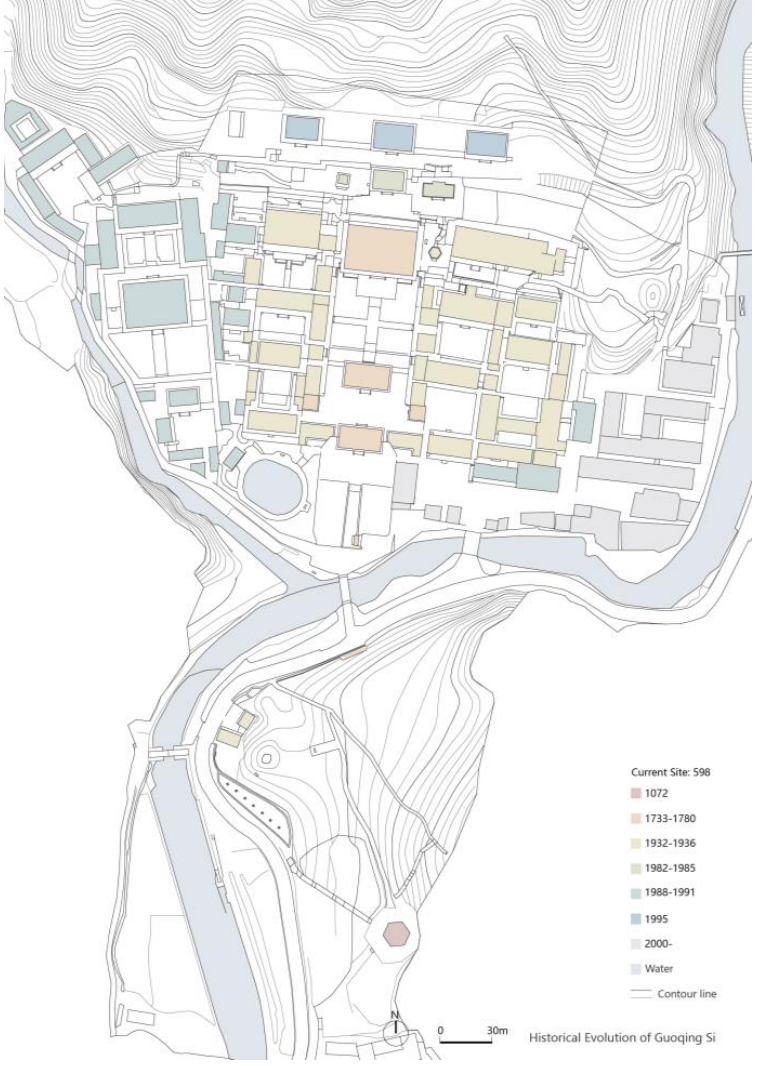
Figure 15. Historical evolution of Guoqing Si.